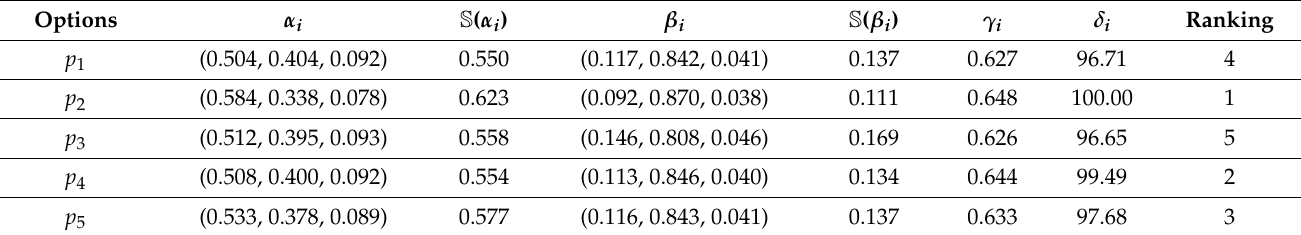
Table A9. The results for prioritizing BESSs using